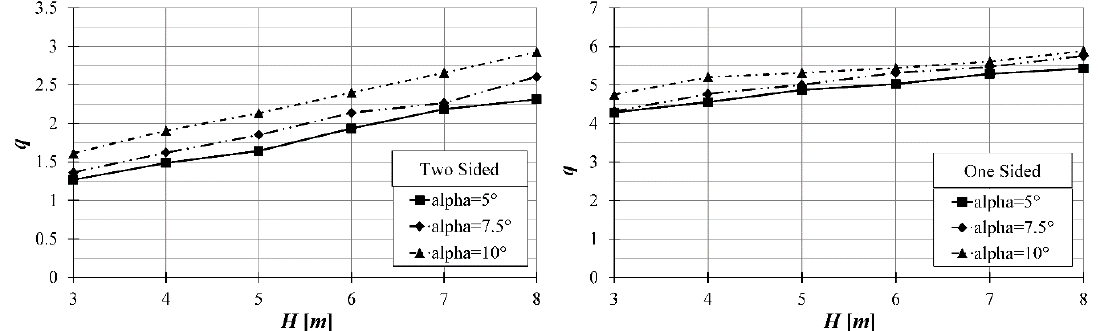
Figure 9. Force reduction factor q versus height H —Unreinforced block, Spectrum A2 .